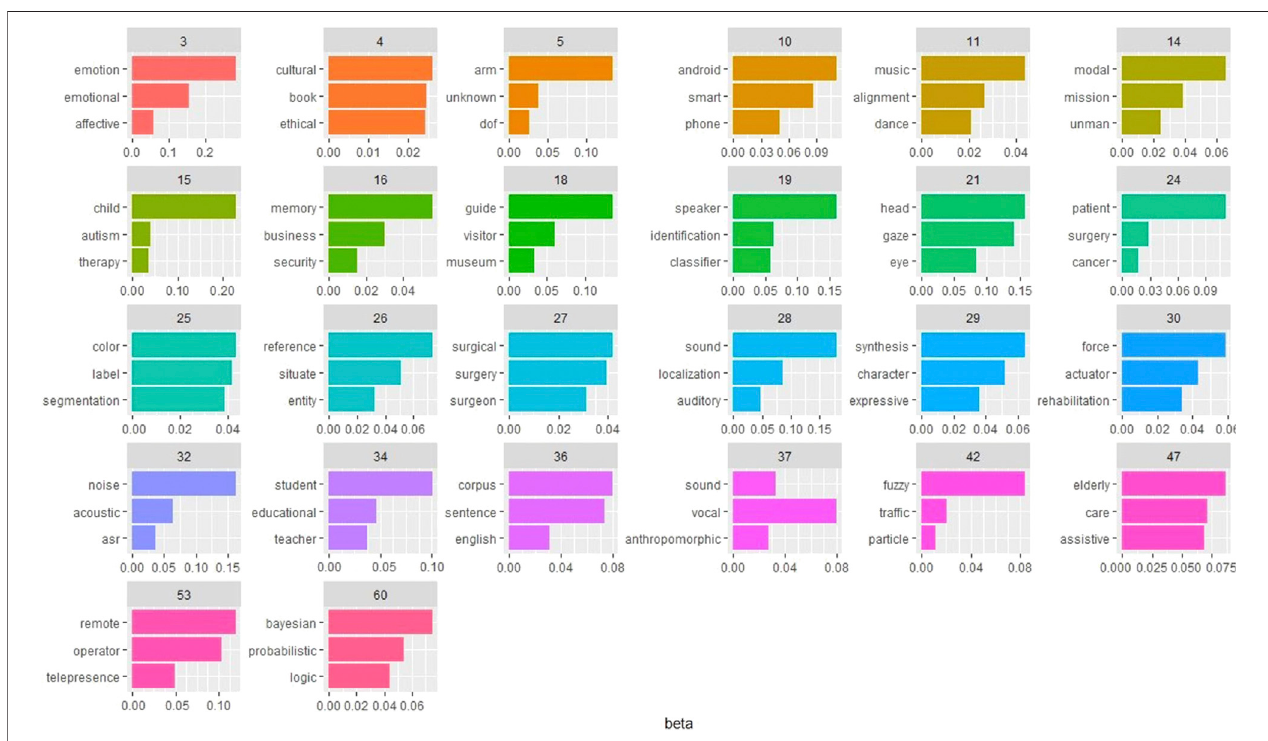
FIGURE 6 | Top topics. For each topic, the three top terms are displayed. beta represent the probability that the term belongs to that speci fi c topic.